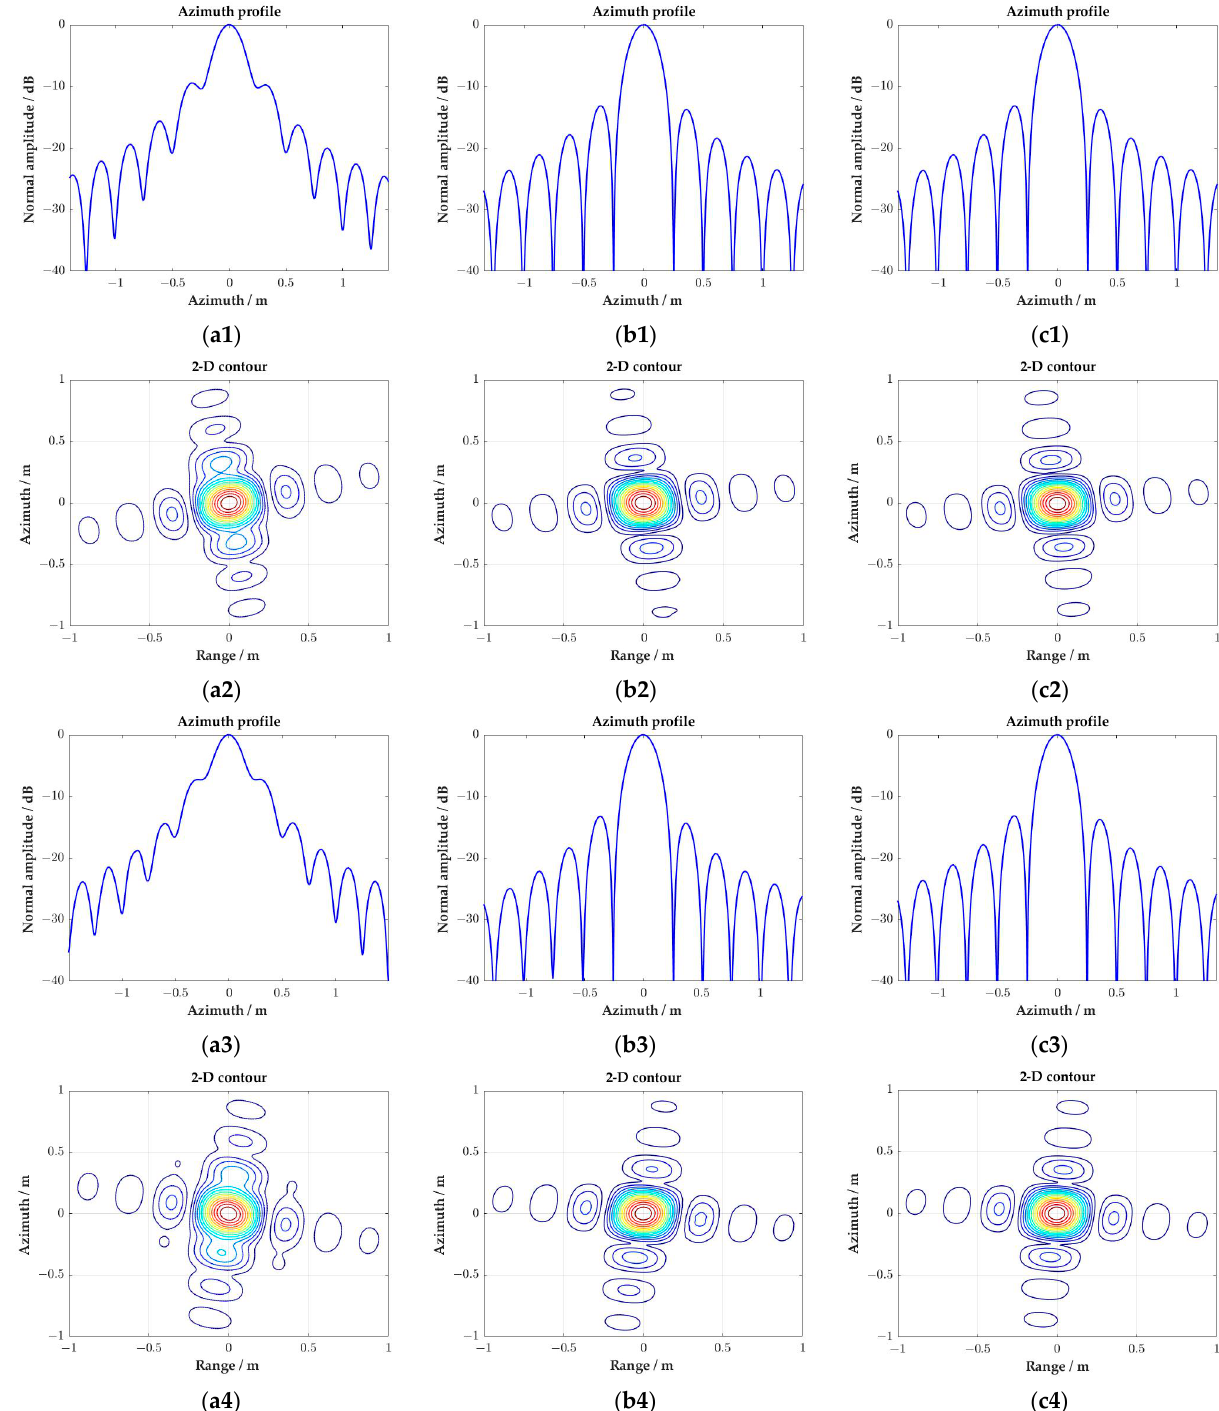
Figure 11. Evaluated results of azimuth profile and two-dimensional contour for the chosen targets corresponding to 0.25 m azimuth resolution. ( a1 – c1 ) The azimuth profile of Target 1 before spatial variance compensation, after Doppler phase perturbation in MHCA, and after azimuth-time resampling in JTDRA, respectively. ( a2 – c2 ) The azimuth two-dimensional contour of Target 1 cor-